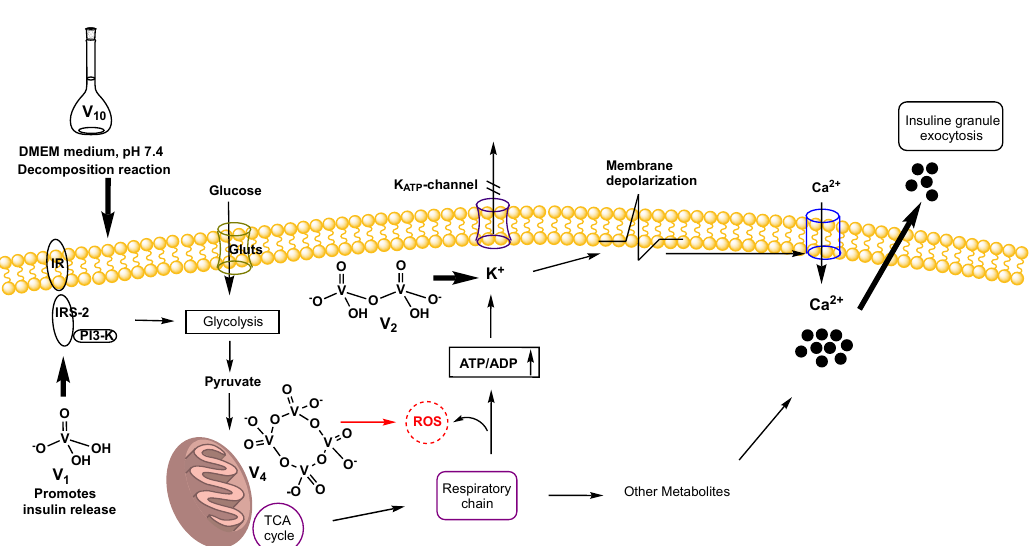
Figure 7. Effect of the vanadium compounds (30 μM concentration) on the insulin release in βTC-6 cells with 10 mM of glucose and 30 μM of repaglinide. All the values are the mean ± SD. * p < 0.05 vs. untreated control cells.